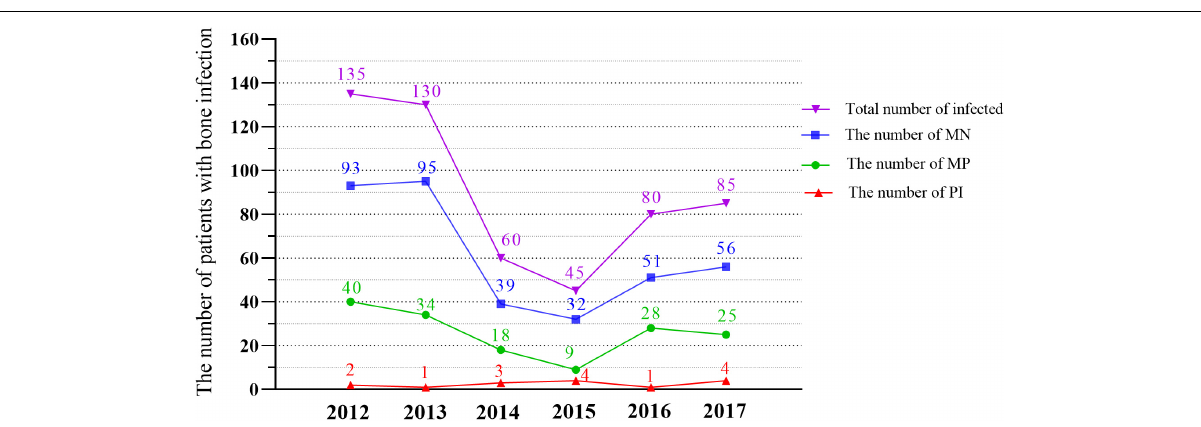
FIGURE 2 | Quantitative trends of MN, MP, PI and the total Bacteria isolated in different years (2012–2017). MN, monomicr obial infection of negative bacteria; MP, monomicrobial infection of positive bacteria; PI, polymicrobial